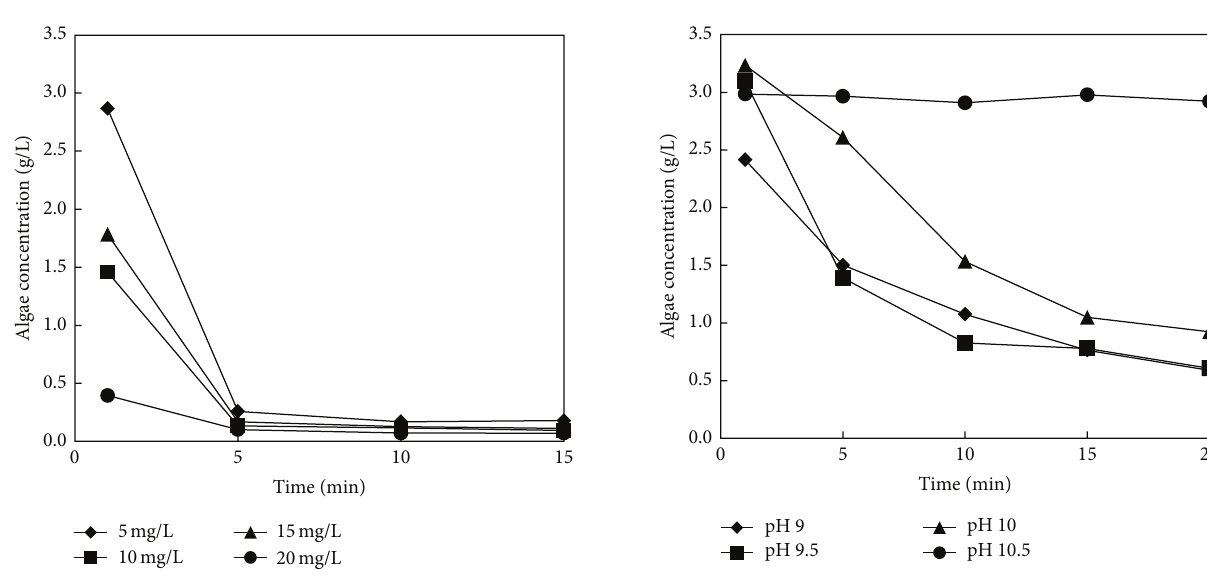
Figure 2: Flocculation by chitosan. Figure 3: Ammonium hydroxide flocculation.